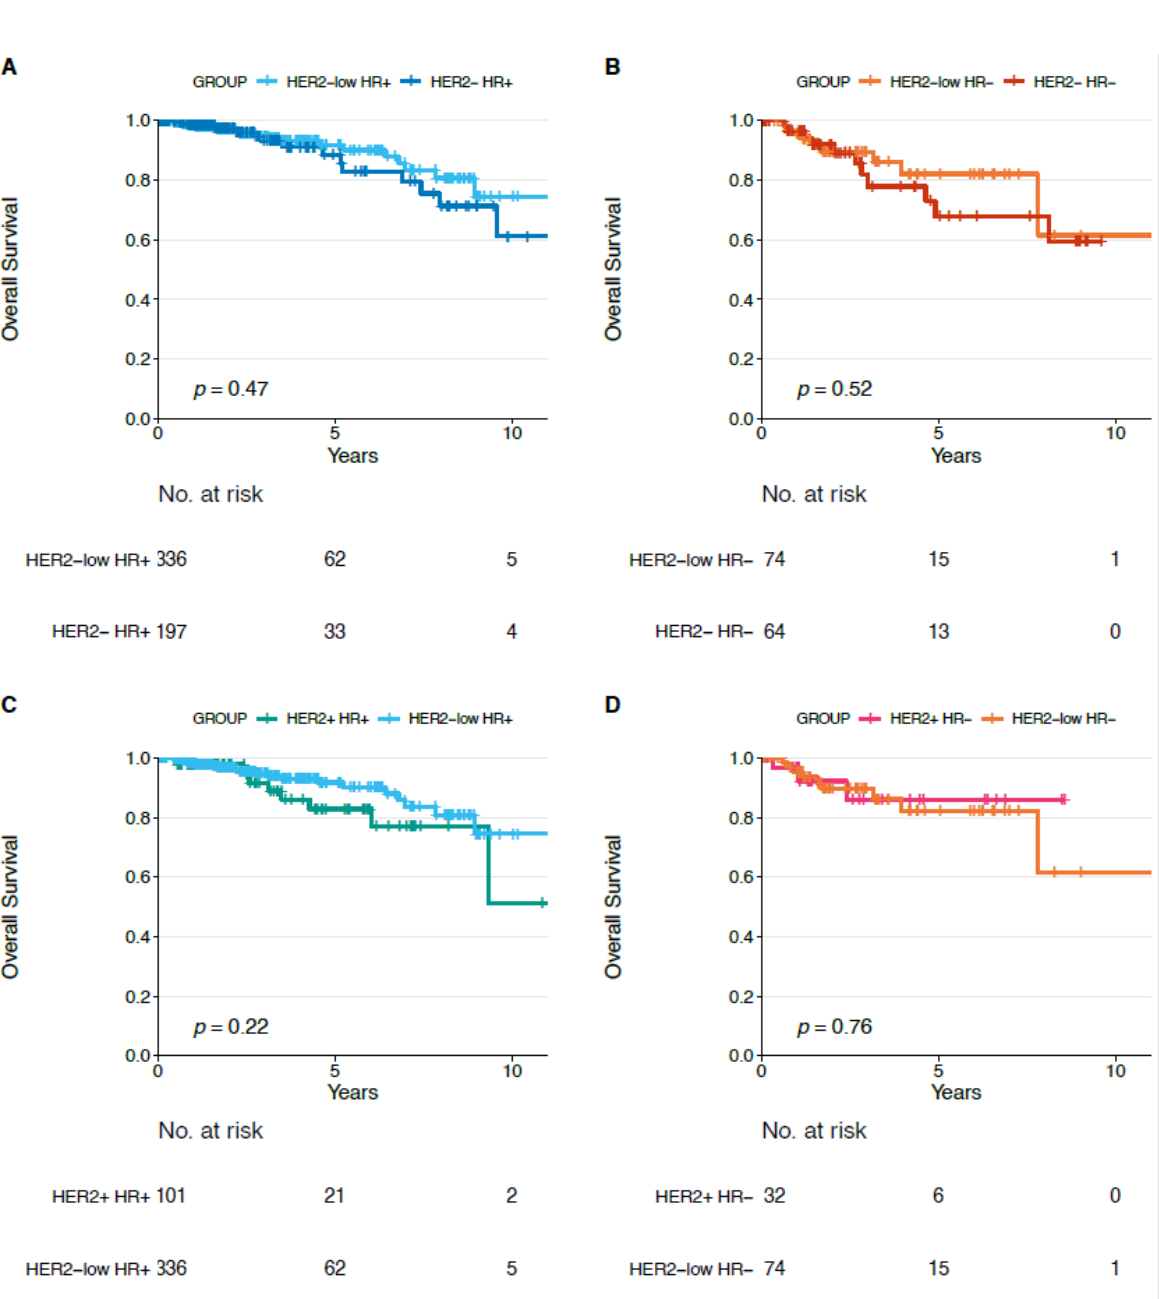
Figure 6. Overall survival in HER2-low/HR+ versus HER2−/HR+ ( A ), in HER2-low/HR− versus HER2−/HR− ( B ), in HER2-low/HR+ versus HER2+/HR+ ( C ) and in HER2-low/HR− versus HER2+/HR− ( D ) tumors. Abbreviations: HR: hormone receptor.